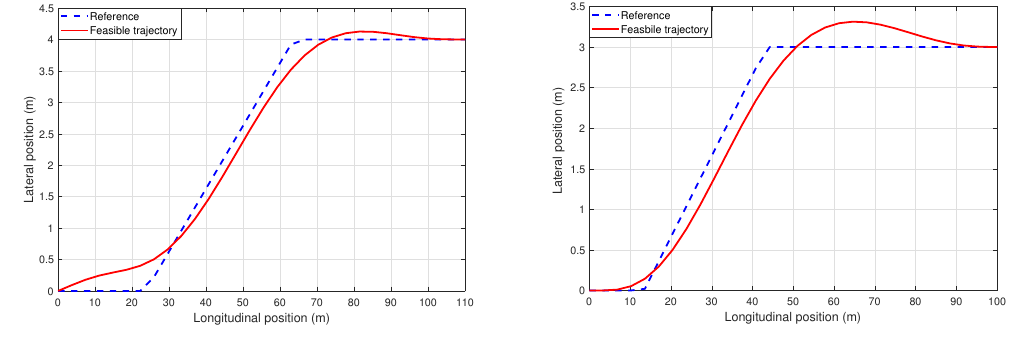
Figure A1. Computed